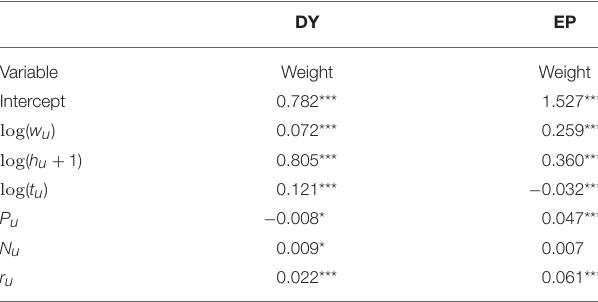
TABLE 5 | Linear regression coefficients and p -values for log ( k u + 1) from the rest of the user metrics (normalized), for Dooyoo (DY) and Epinions